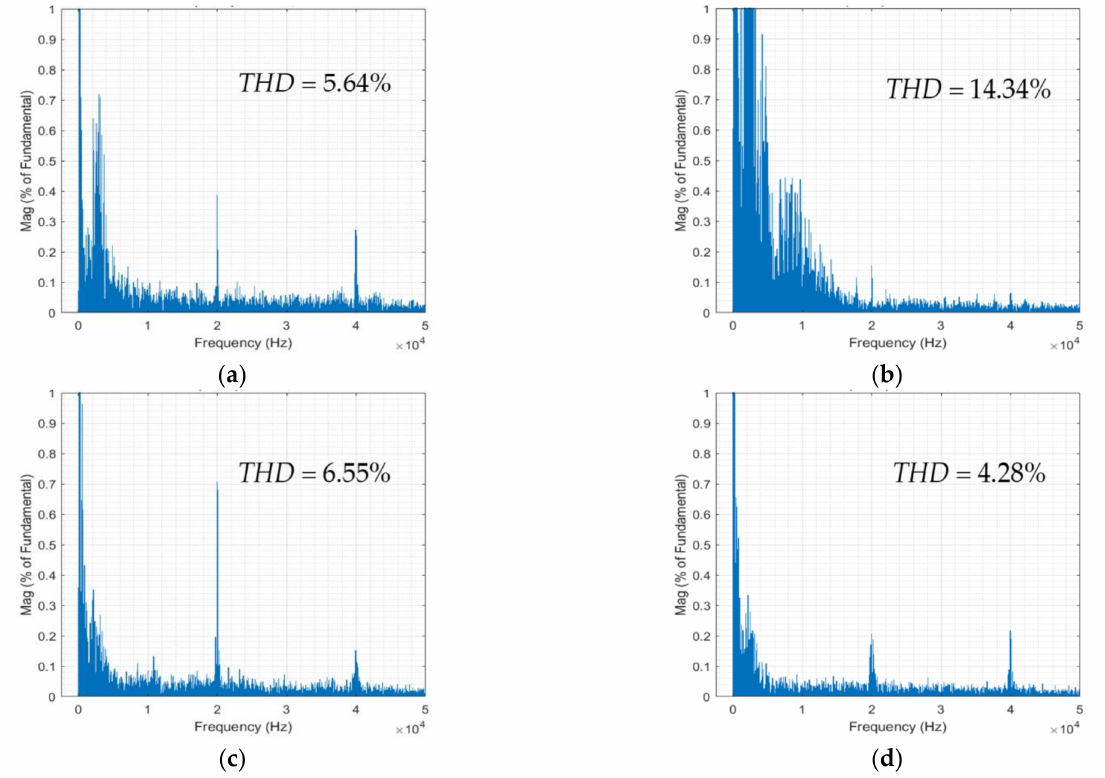
Figure 16. FFT analysis of the input current. ( a ) PI-ICC; ( b ) FCS-MPC; ( c ) MP-DPC; ( d ) the proposed